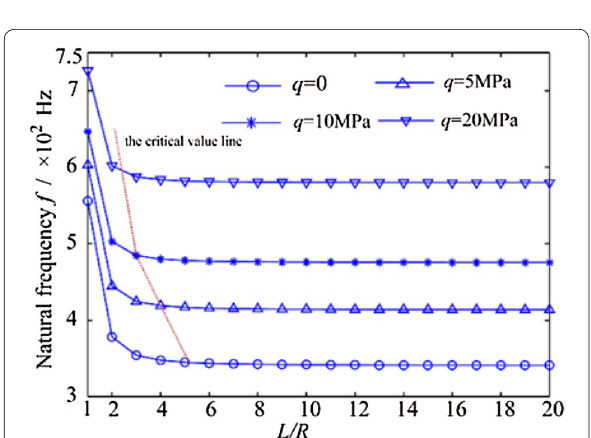
Figure 4 Variation of the natural frequency against L / R ratio for several uniformly distributed pressures